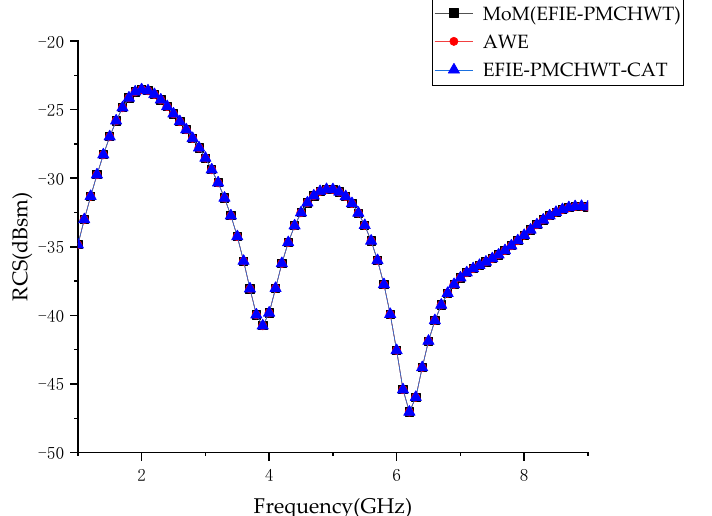
Figure 8. RCS frequency response of the coated composition of the MoM (EFIE-PMCHWT), AWE, and EFIE-PMCHWT-CAT.